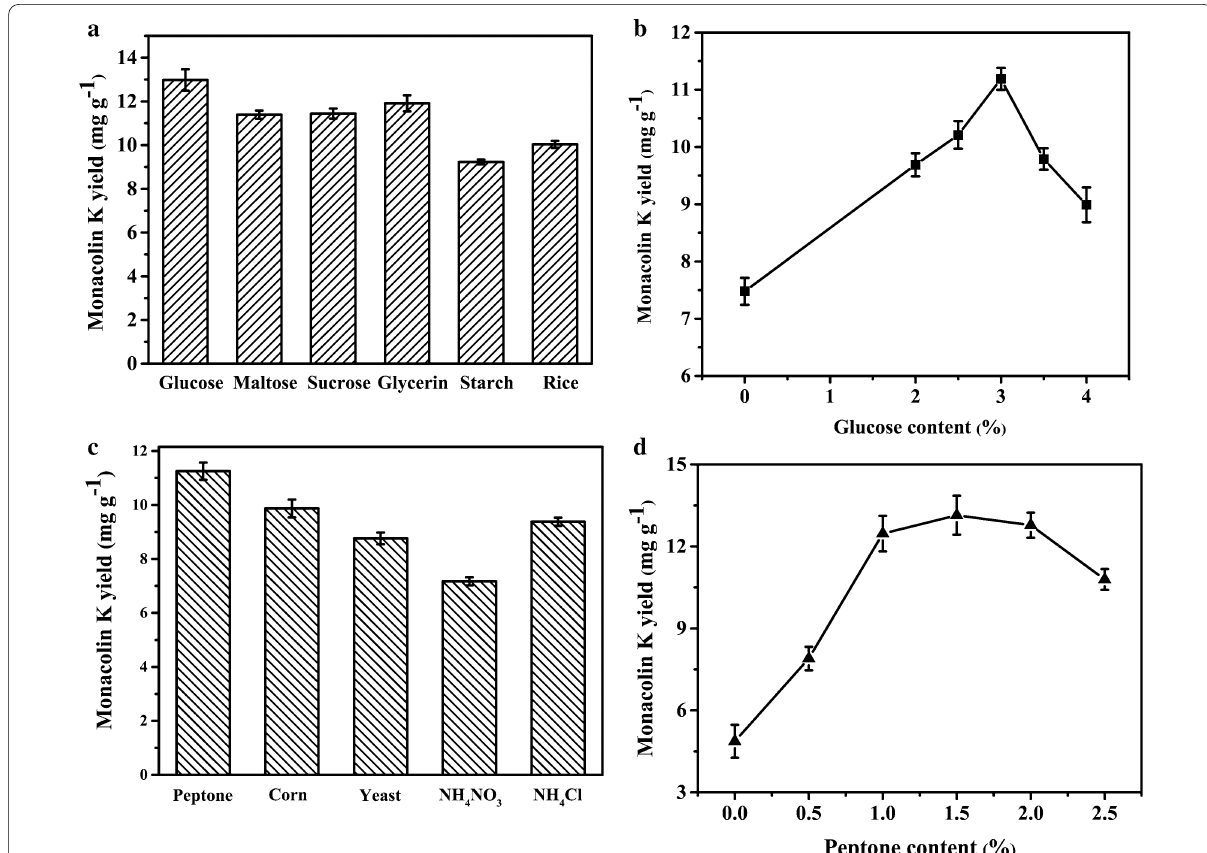
Fig. 2 Influences of different carbon sources ( a ) and glucose content ( b ), nitrogen sources ( c ) and peptone content ( d ) on the yield of Monacolin K